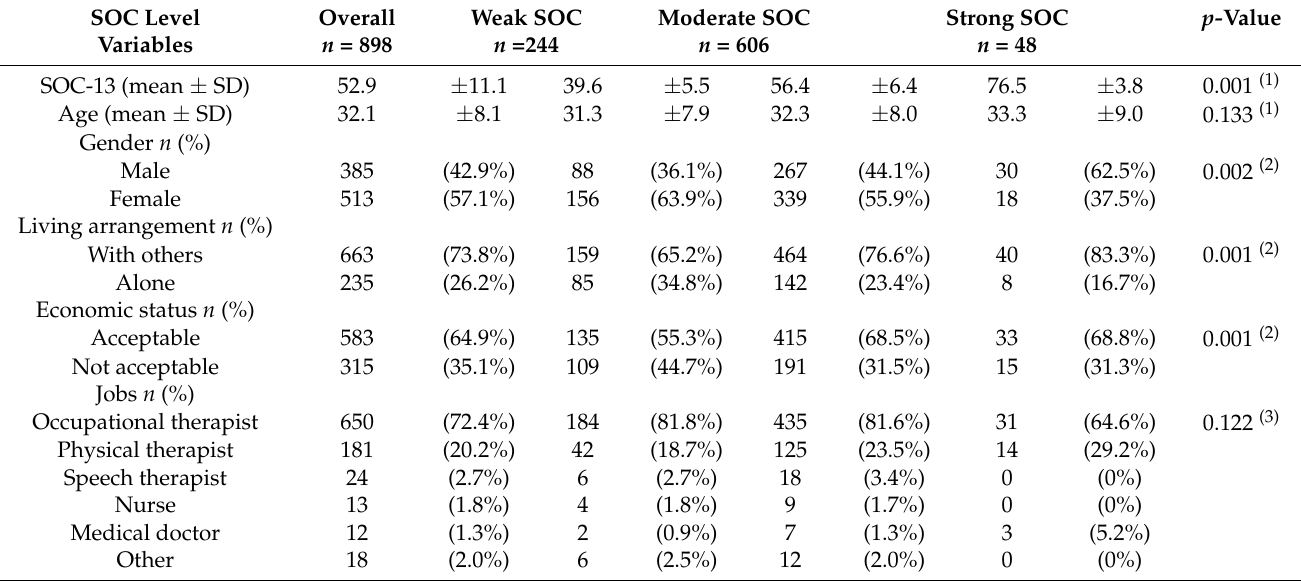
Table 1. Demographic characteristics of study participants ( n =